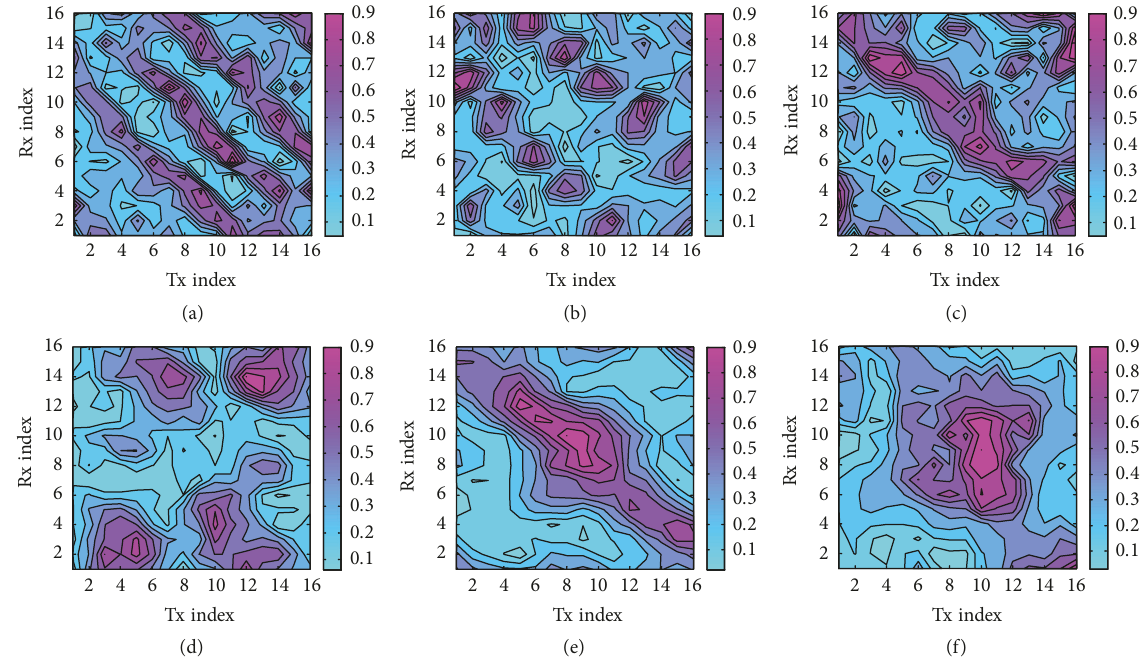
Figure 14: Measured amplitude matrices at (a) 15m, (b) 25 m, (c) 35 m, (d) 65 m, (e) 75 m, and (f) 85 m.